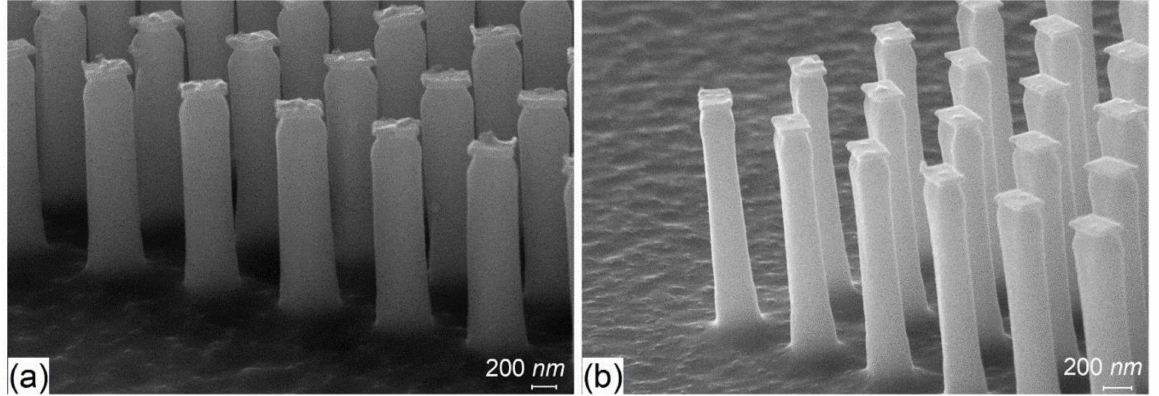
Figure 5. E-beam rectangular nanostructures patterned in the: ( a ) Al and ( b ) Ti films.